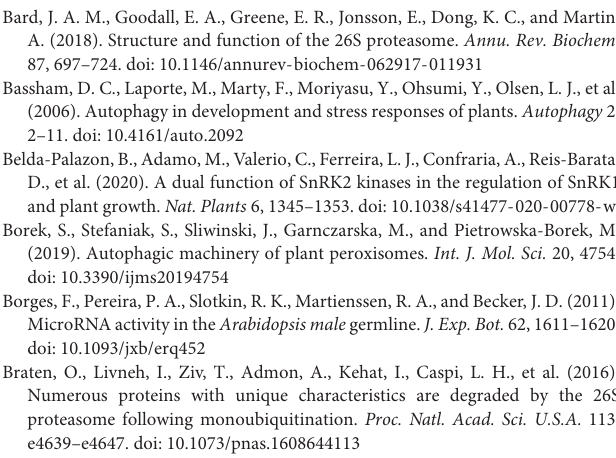
Supplementary Table 1 | DNA methylation of Arabidopsis ATG